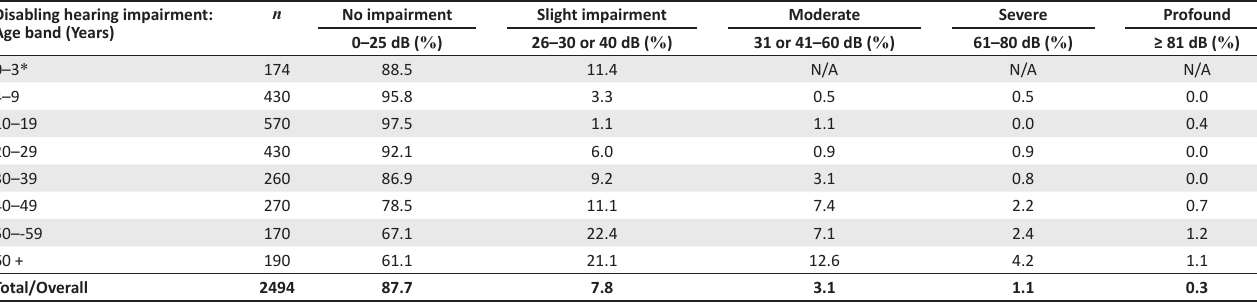
TABLE 1: Percentage ( % ) of participants by degree of hearing impairment and age category. Disabling hearing impairment: Age band (Years)